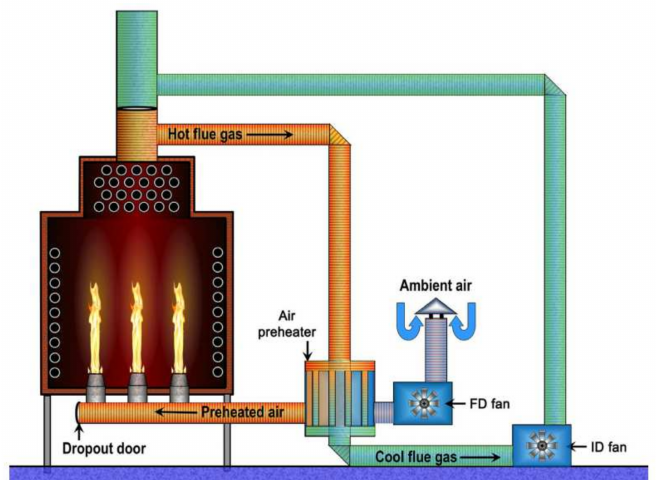
Figure 7. Schematic representation of a balanced draft system